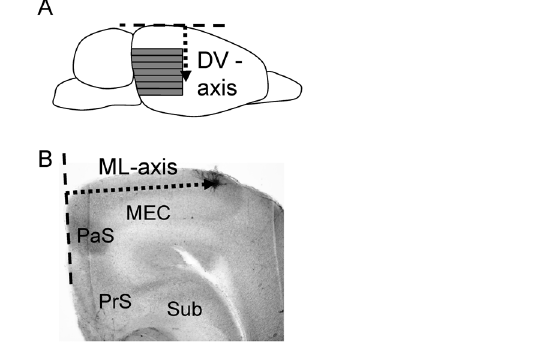
Figure 1. Measurements of anatomical locations of medial entorhinal cortex layer II neurons. (A) Measurement along the dorso-ventral (DV) axis. In the schematic drawing of a rat brain, each gray strip corresponds to one brain slice. The arrow indicates the distance from the cortical surface to the slice, which was used as the location of the recorded neuron along the DV-axis. (B) Measurement along the medio-lateral (ML) axis. On the photo of the brain slice, the edge of the slice along the parasubiculum (PaS) was first determined (dotted lines). The arrow indicates the distance from the dotted lines to the recorded neuron, which was used as the location of the recorded neuron along the ML-axis. PrS: Presubiculum. Sub: Subiculum.